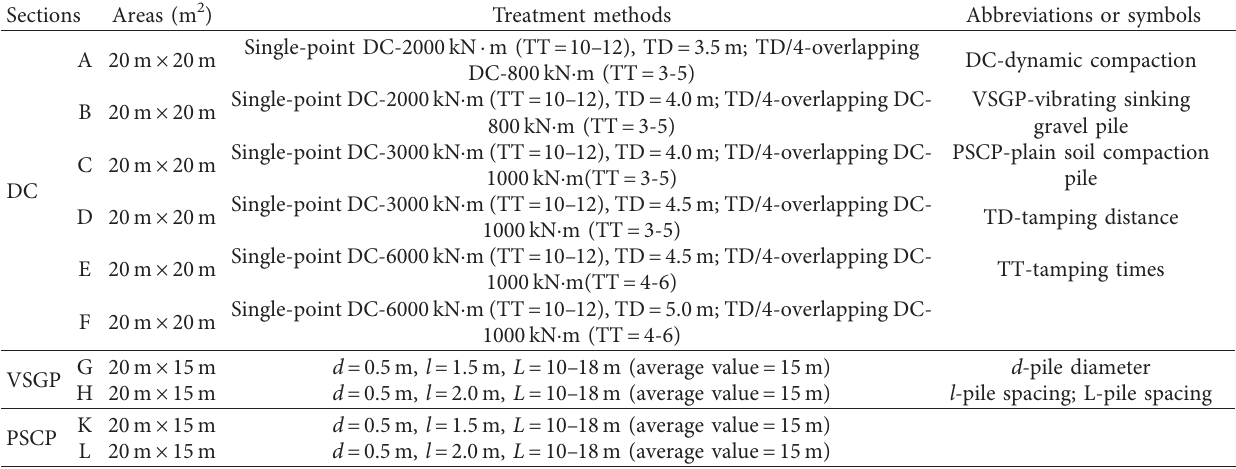
Table 3: Foundation soil treatment methods.